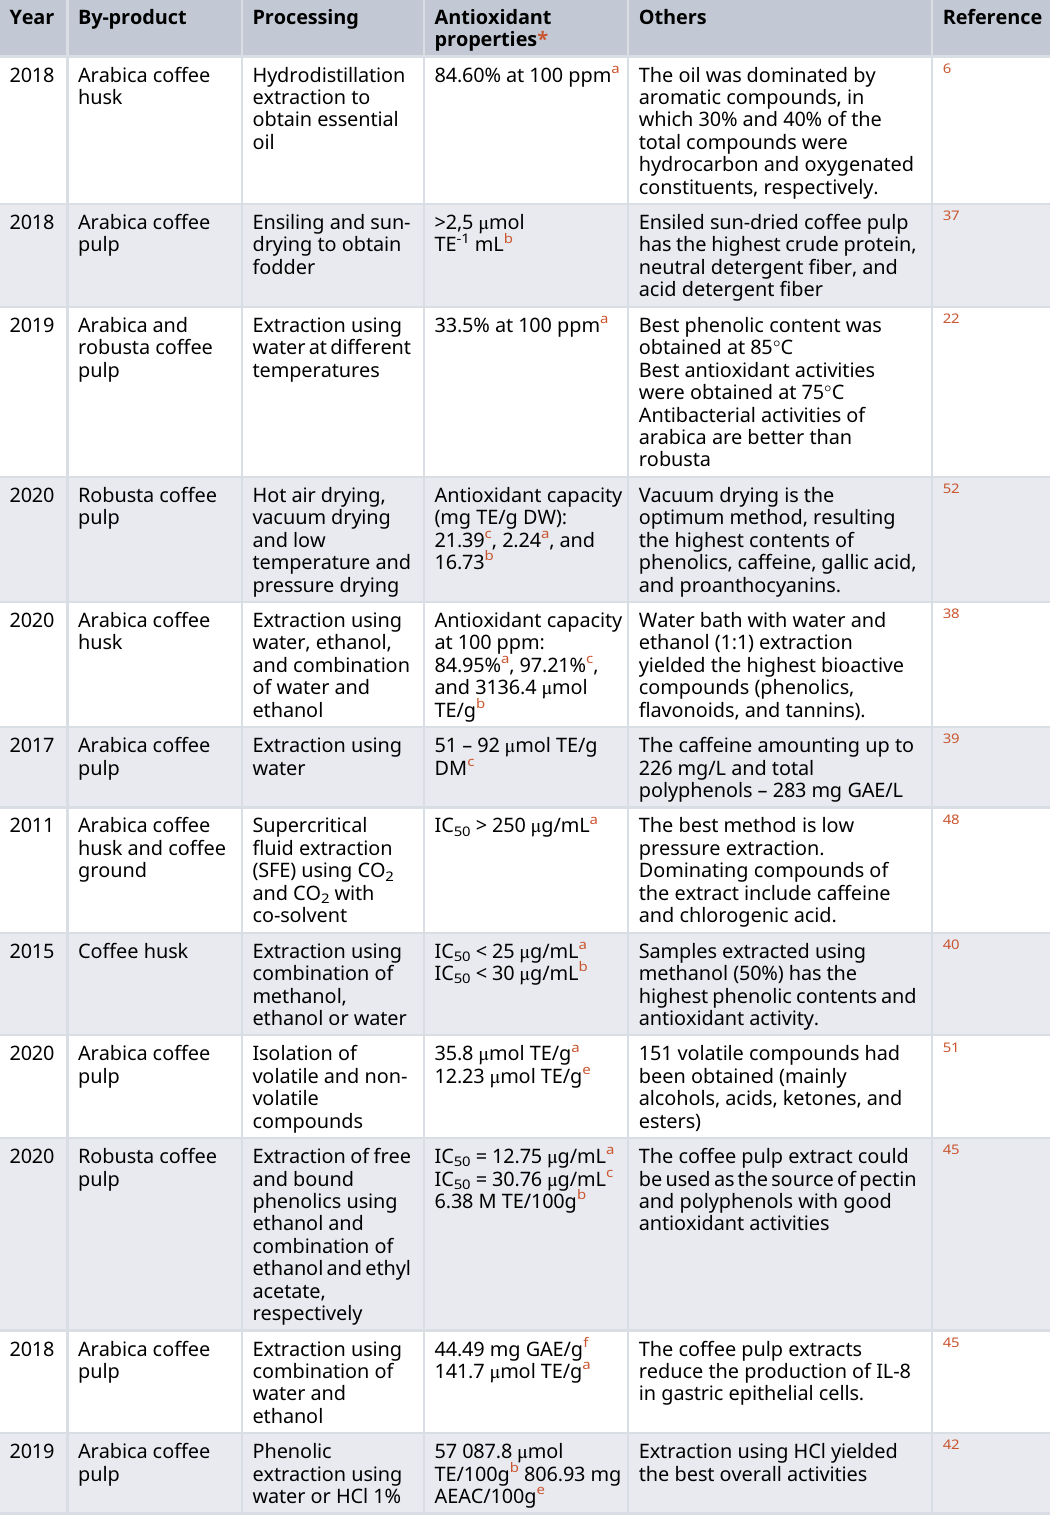
Table 1. Antioxidant properties of coffee